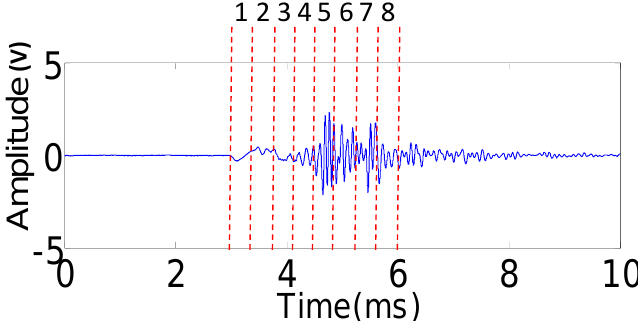
Figure 8. Eight sections of sound signals for